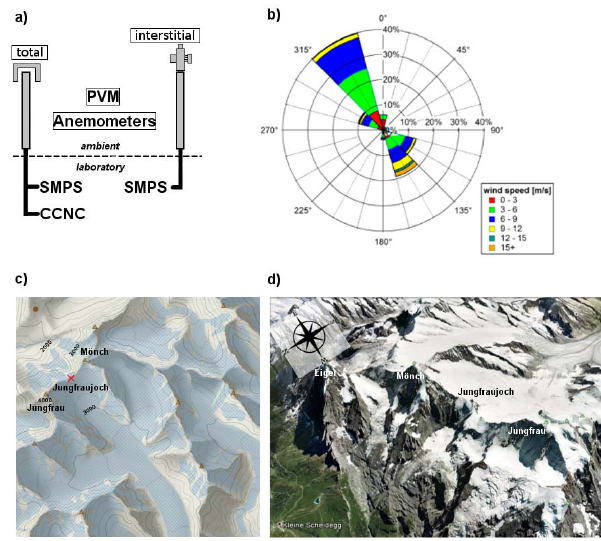
Fig. 1. In (a) the measurement setup is shown in a sketch with the two different inlet systems. An overview of the major wind directions during CLACE2011 (data source: MeteoSwiss) around the JFJ is shown in (b) and the corresponding altitude profile in (c) . In (d) a satellite picture is shown looking towards Southeast ( © GoogleEarth, 9 January 2010,